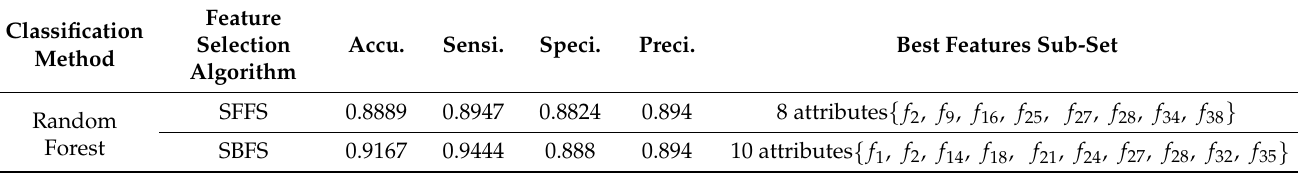
Table 3. Random forest classification results (the definition of the features can be found in Tables A1 and A2 in the Appendix